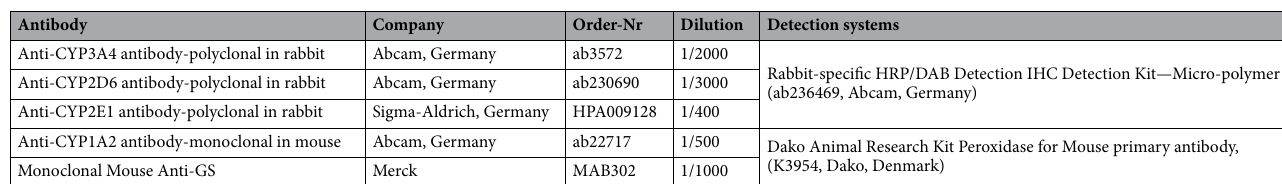
Table 2. CYP antibodies used for IHC-detection of CYP distribution and expression pattern in liver tissue sections.